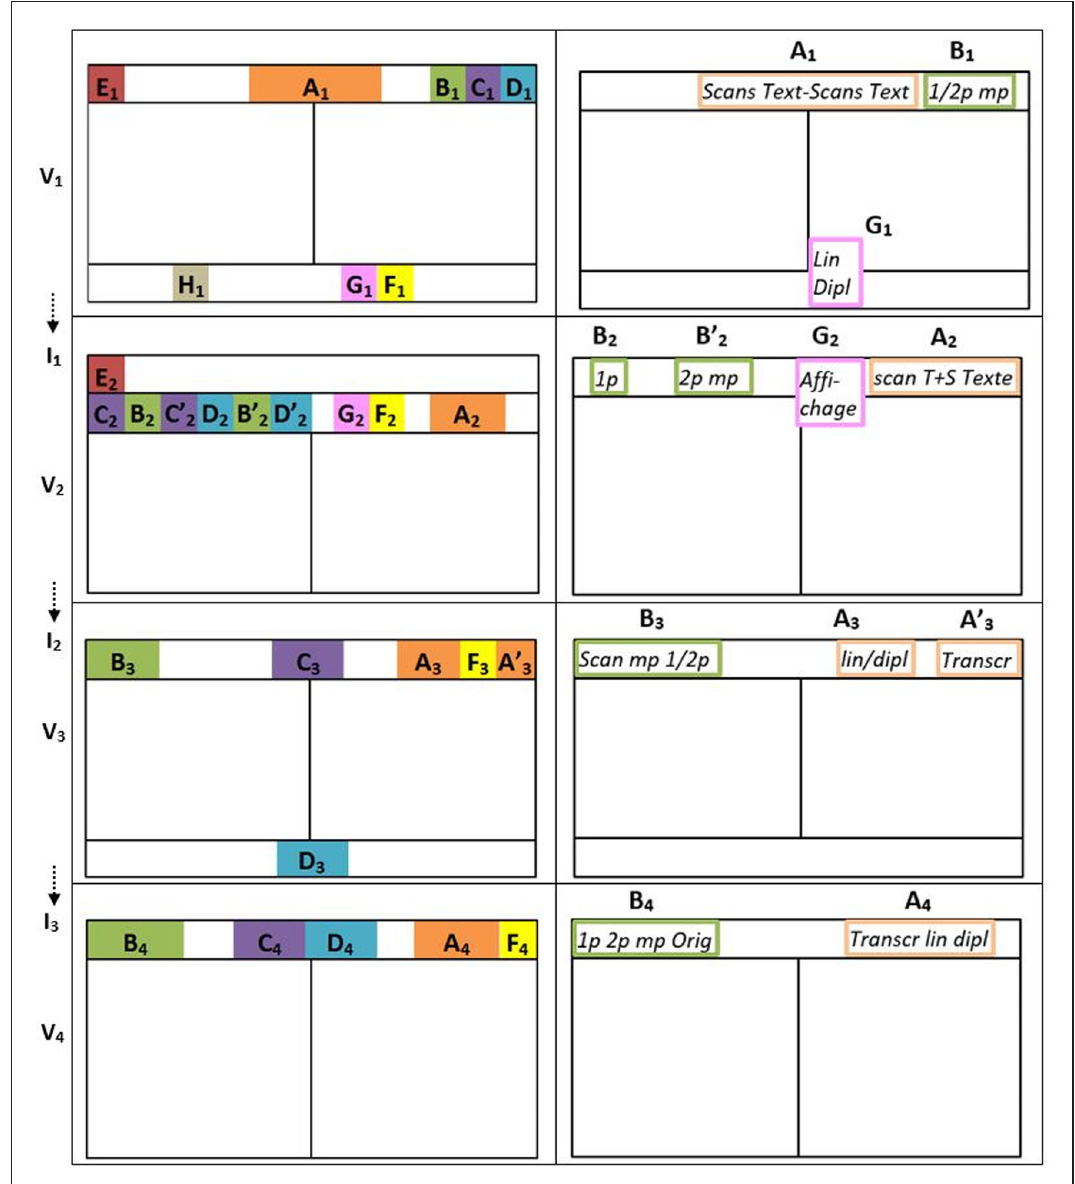
Figure 6: Transviewer mutations of the groups of features (left) and detail of main features from groups A, B (right), V –V , I –I (Abbreviations and symbols: 1p – one-page; 2p – two-page; 1/2p 1 4 1 3 – one/two-page toggle button; mp – multi-page; lin – linear, dipl – diplomatic, lin/dipl – toggle button; Orig – Original; Transcr – Transcription [capitals for labels, lowercase for